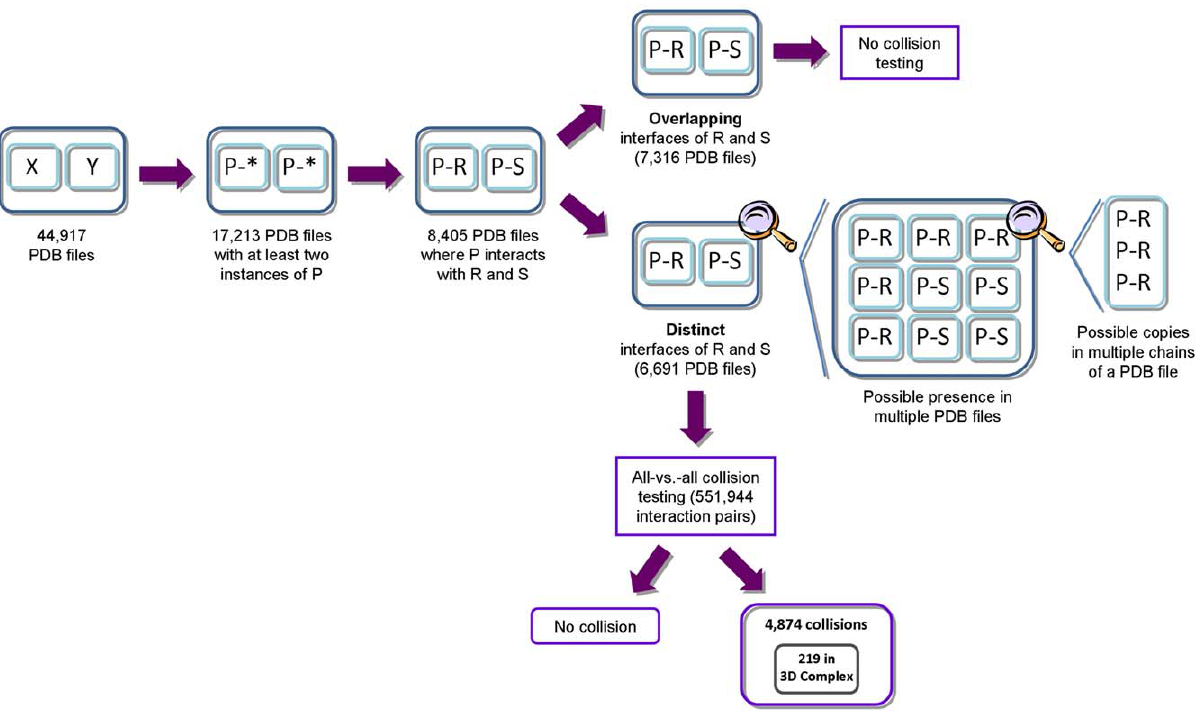
Figure 3. Overview and results of our structure collision approach. The flow chart illustrates the necessary steps for identifying 3D structure collisions of interacting proteins. Additionally, the number of PDB files and interaction pairs is given.